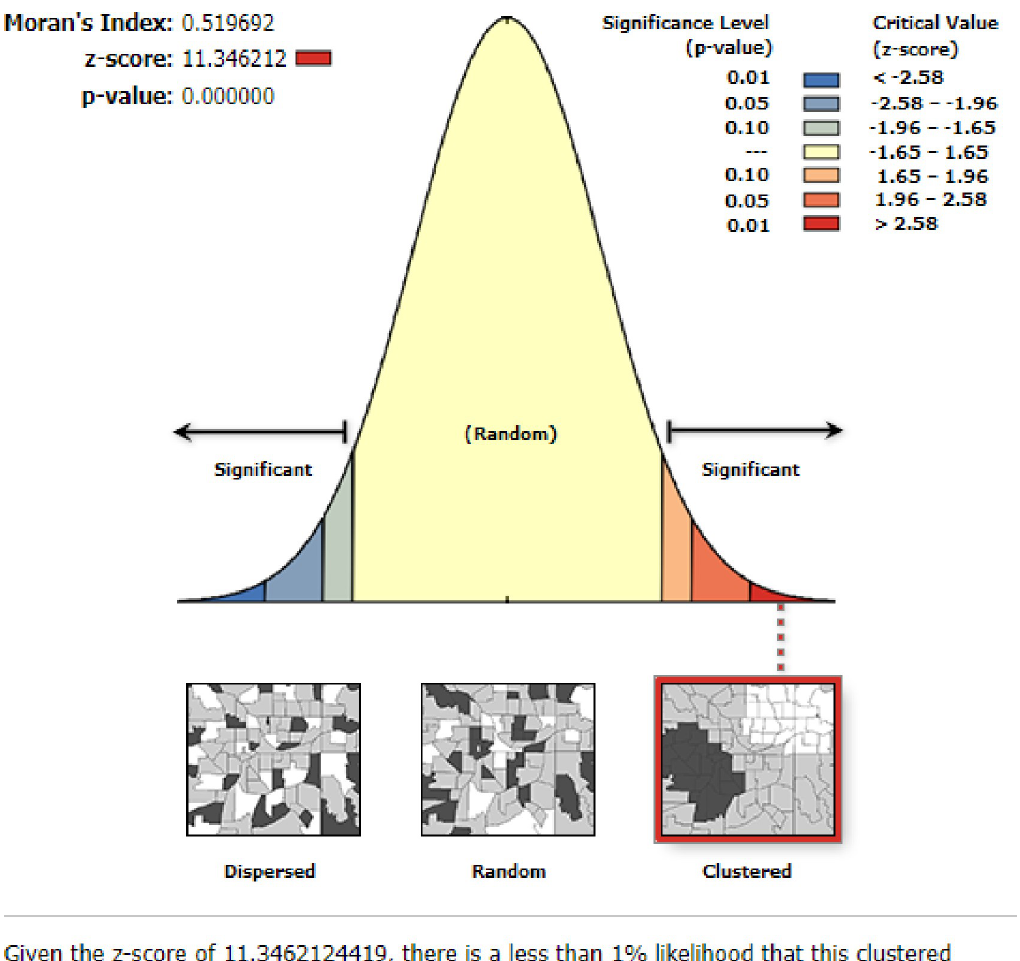
Fig 1. Spatial autocorrelation of home delivery in Ethiopia, MEDHS